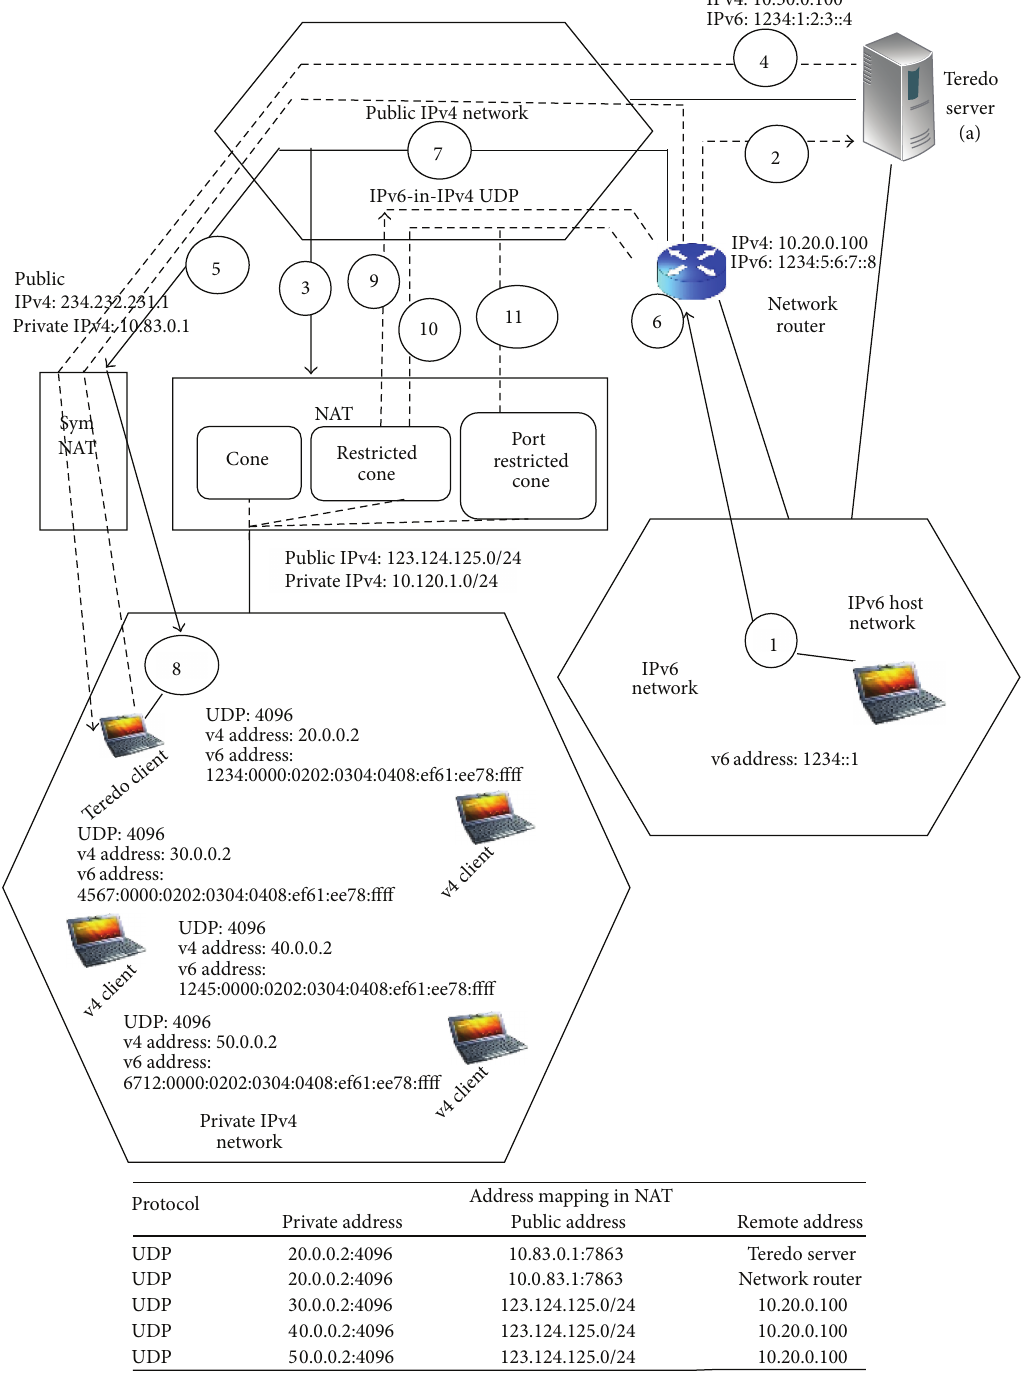
Figure 2: Multifarious Sym Teredo